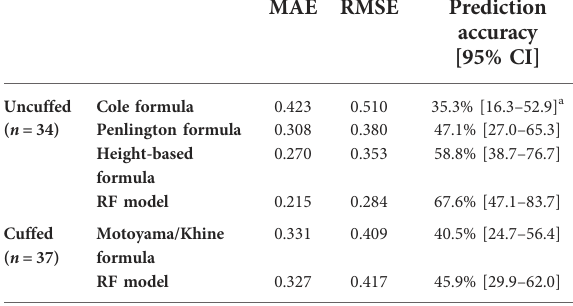
TABLE 3 External validation of machine learning